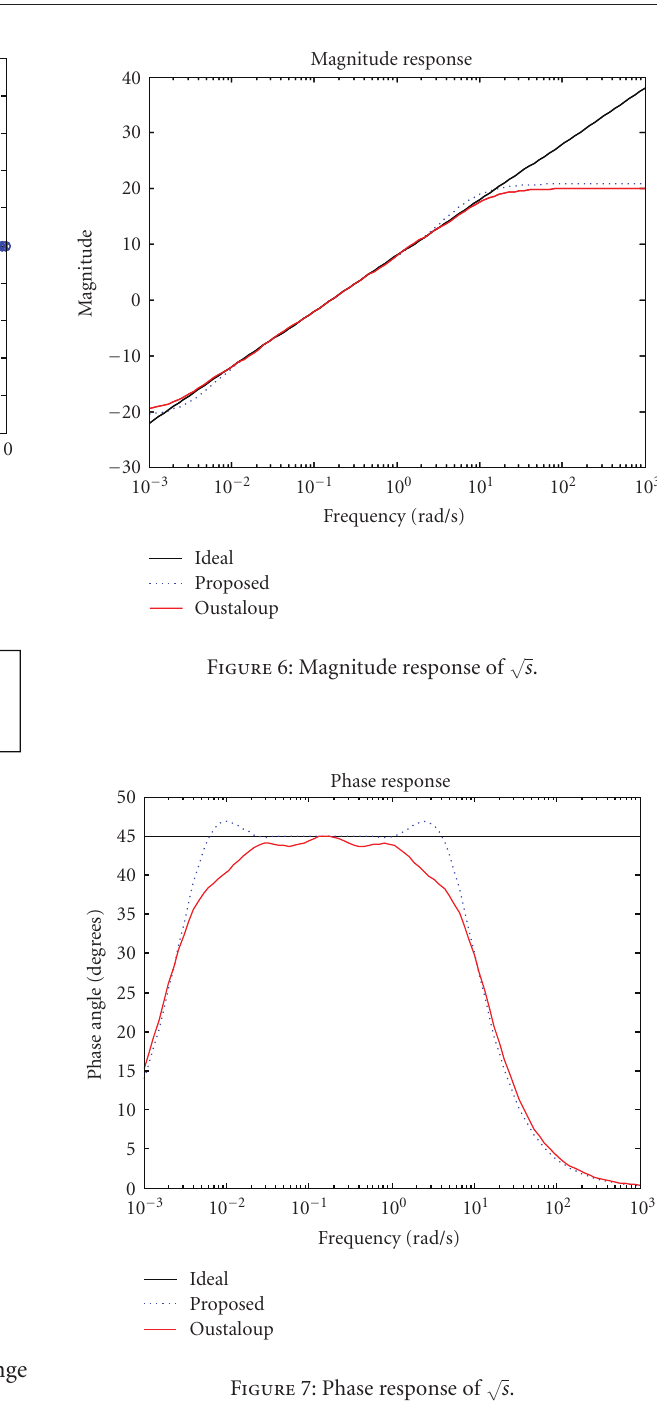
Figure 7: Phase response of